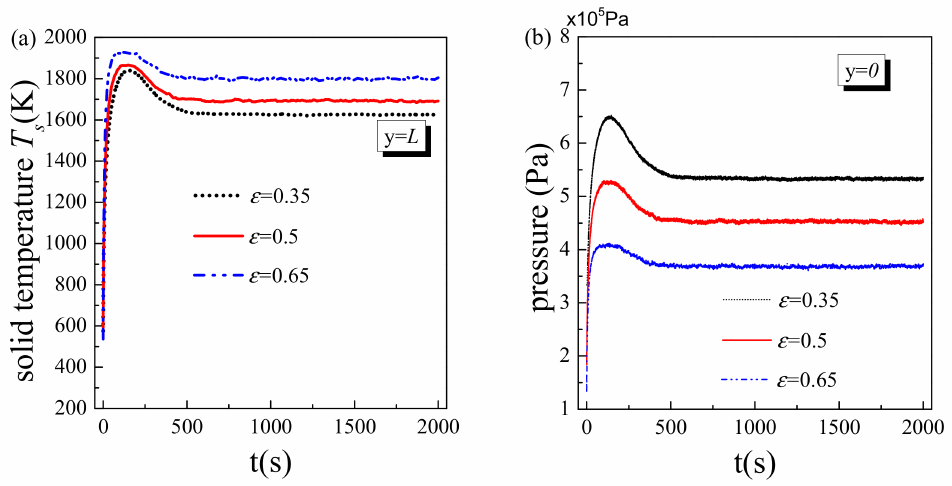
Figure 6. Transient results at different porosity: ( a ) solid temperature at the hot side; ( b ) fluid pressure at